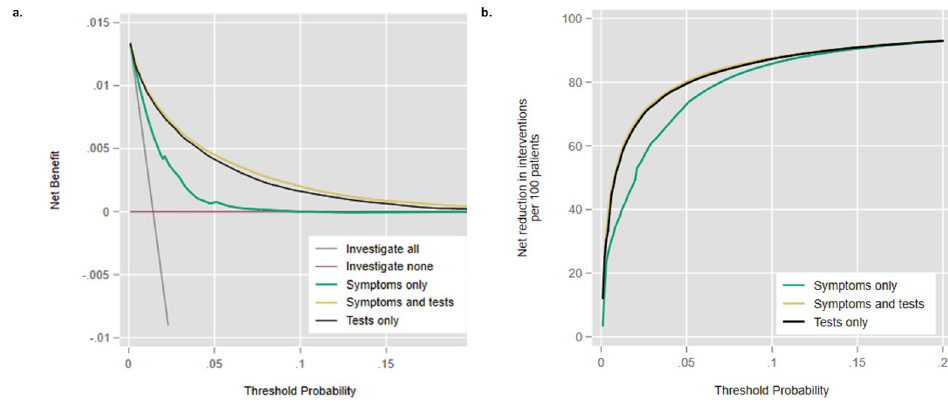
Fig 2. Decision curve analysis comparing the three models in terms of net benefit (Fig 2a) and investigations avoided (Fig 2b). DCA, decision curve analysis.